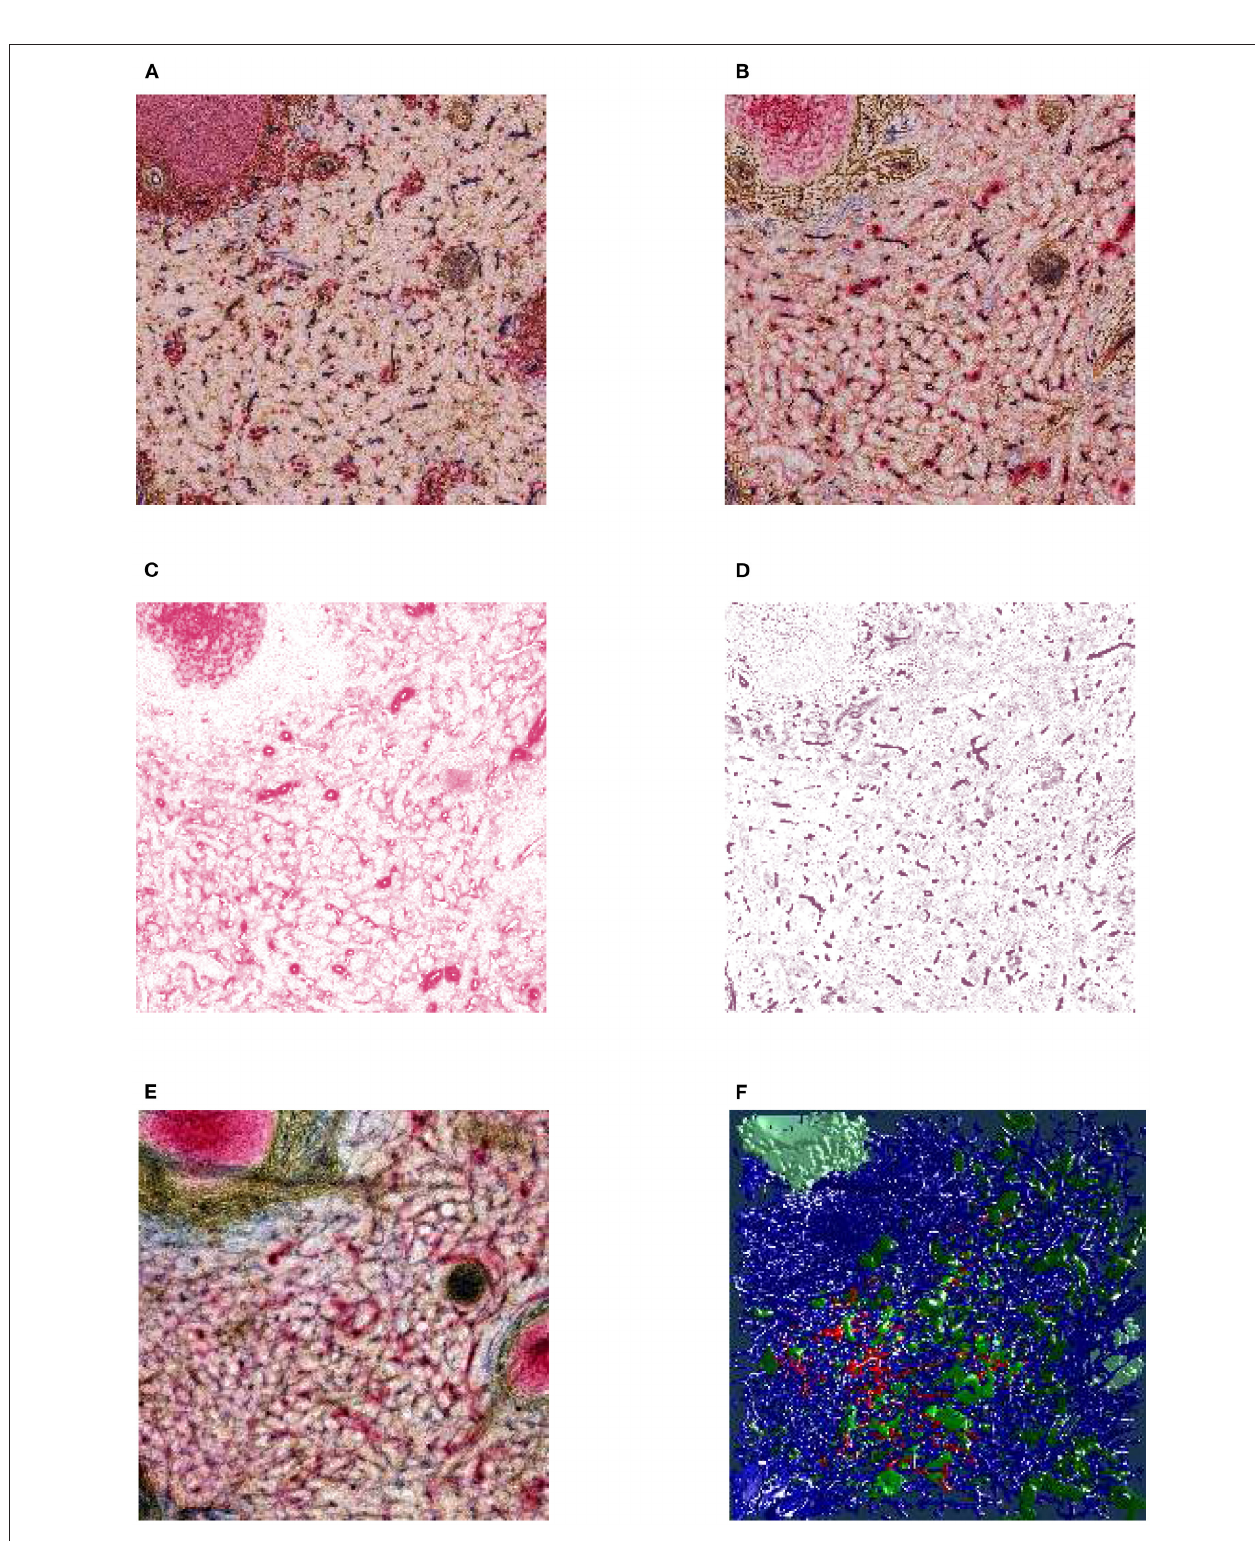
FIGURE 3 | From section images to final results: A human spleen section is stained for SMA (brown), CD34 (blue), and either CD271 (red) or CD20 (red), this is the “Sheaths alternating” data set. (A) The region of interest (ROI), staining of B-lymphocytes (CD20) in red. (B) The ROI, staining of capillary sheaths (CD271) in red. (C) Result of color deconvolution for CD271 of (B) , a single image. (D) Same, but for CD34. (E) A volume rendering of the first 30 sheath-depicting sections of the ROI.